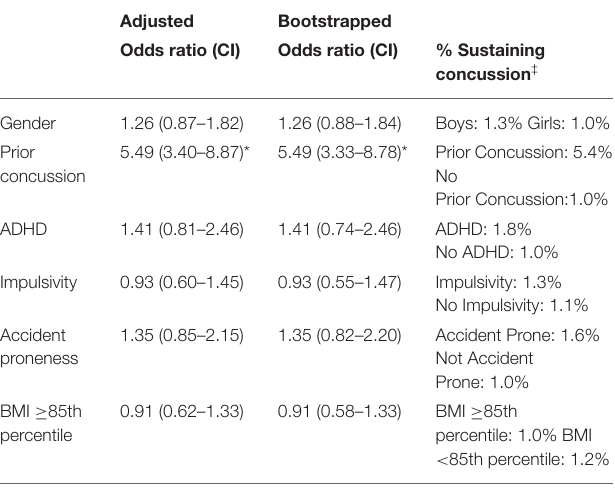
TABLE 2 | Multivariable logistic regression predicting concussion